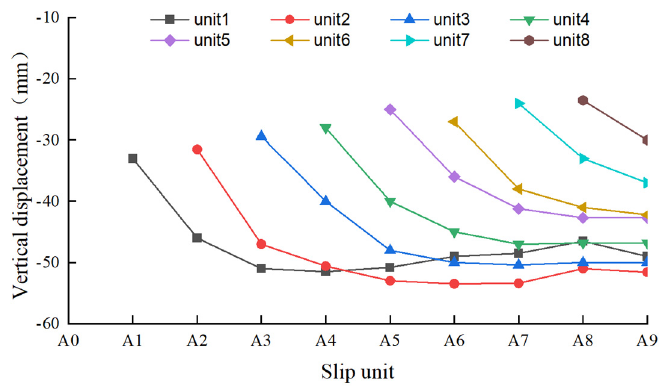
Figure 14. Displacement variation diagram of a control node in the midspan of each unit.